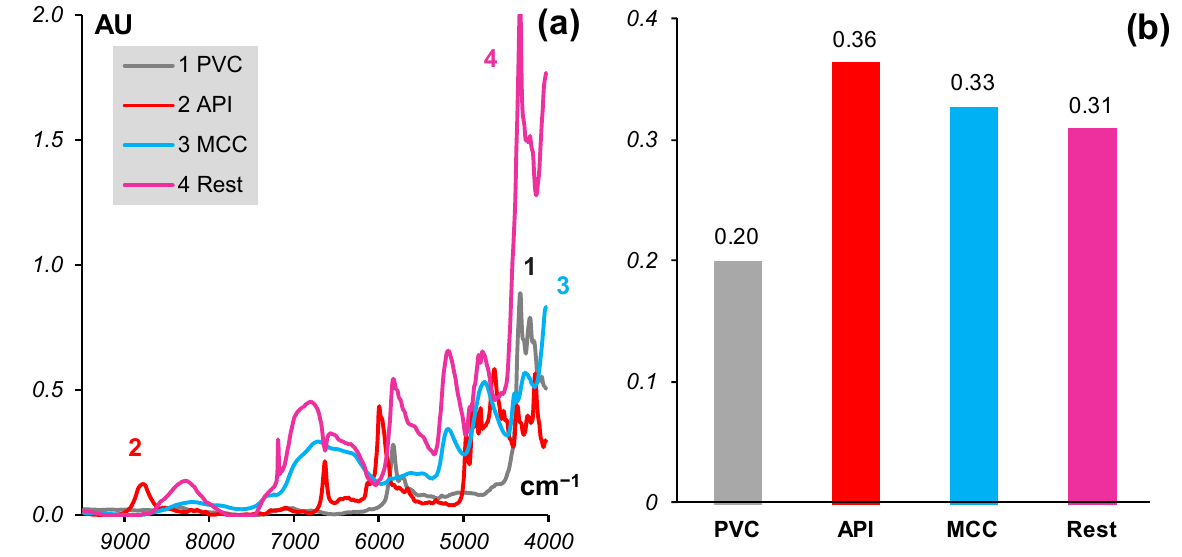
Figure 3. ( a ) Spectrum of Rest and spectra of other components; ( b ) Known ( API , MCC , Rest ) and estimated ( PVC ) concentrations of components.